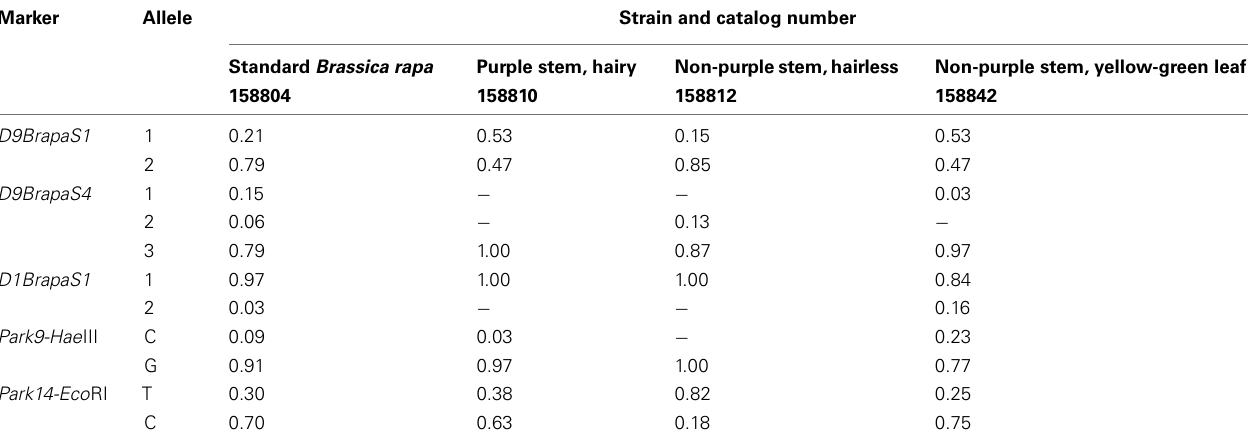
Table 4 | Estimated marker allele frequencies in fast plants strains from Carolina Biological Supply.